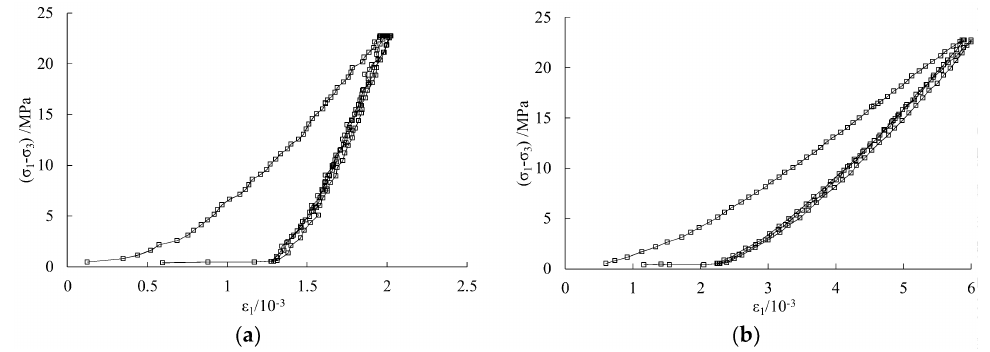
Figure 10. Deviatoric stress-axial strain curves of different specimens under high stress: ( a ) Coarse sandstone; ( b )